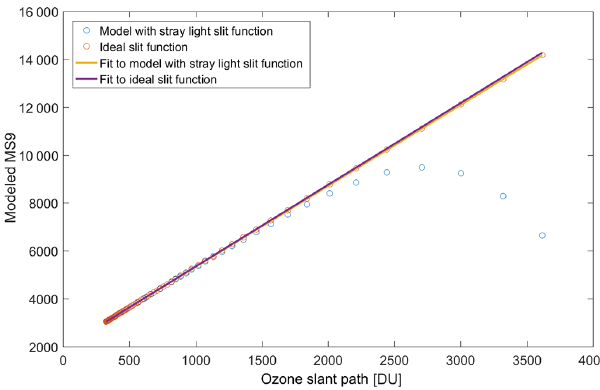
Figure 5. Example of Langley plot fitted to a modeled single Brewer data (see text for the details).